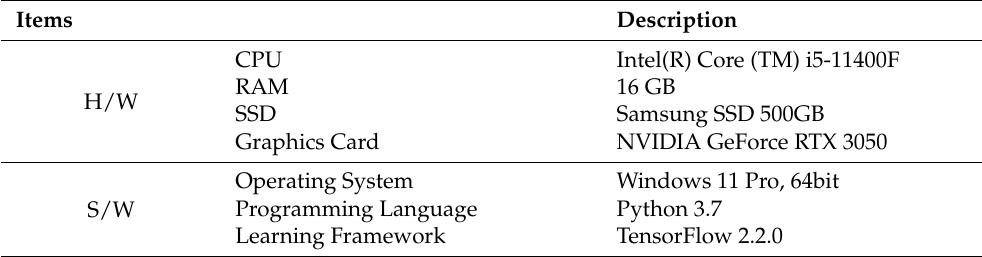
Table 6. Workstation mainframe hardware and software.